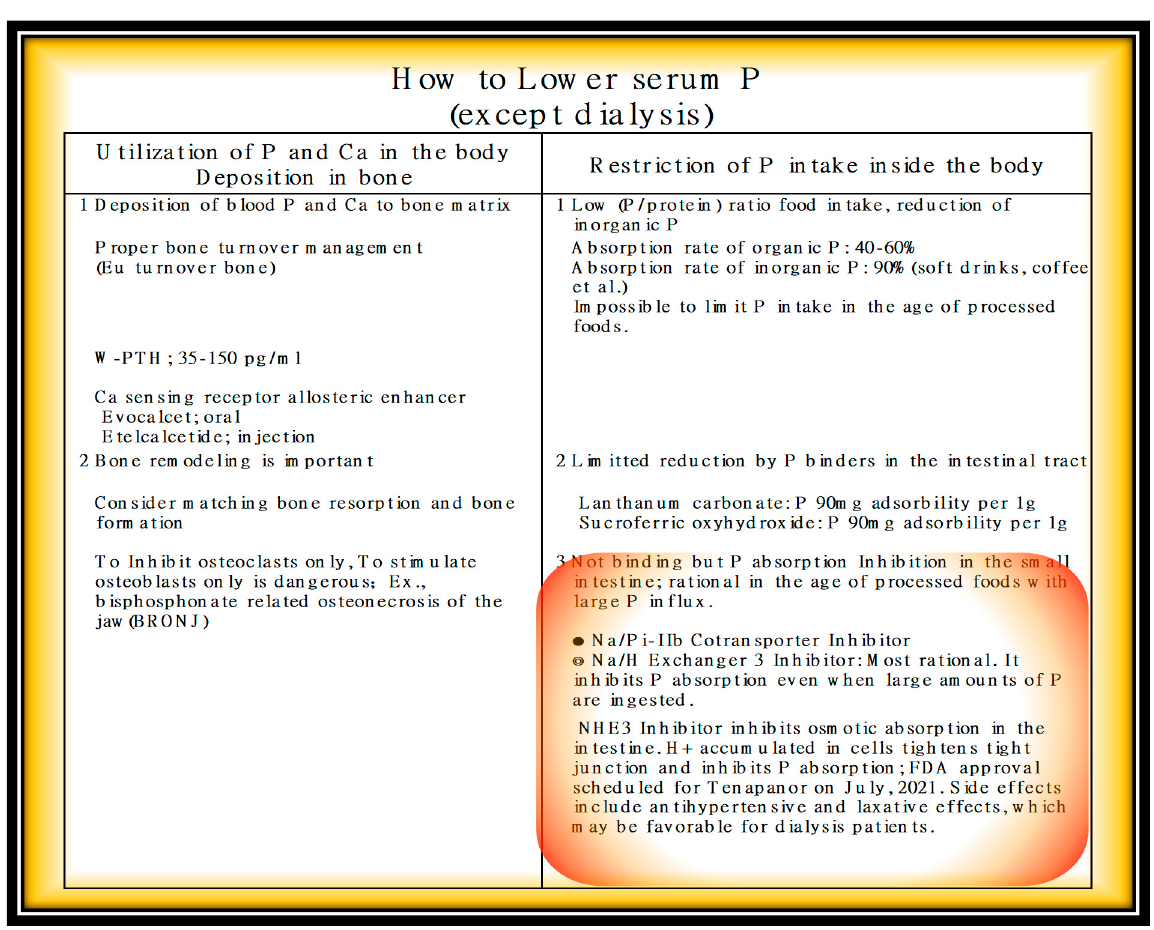
Figure 10. Methods to prevent the invading P. Figure 10. How to lower serum P (except